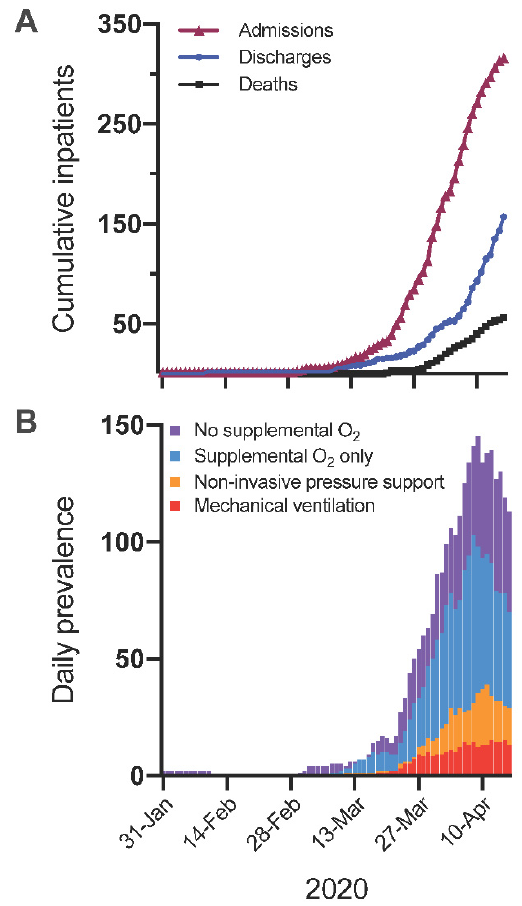
Figure 1. ( A ): Cumulative daily incidence of admissions, discharges and deaths up to censor point